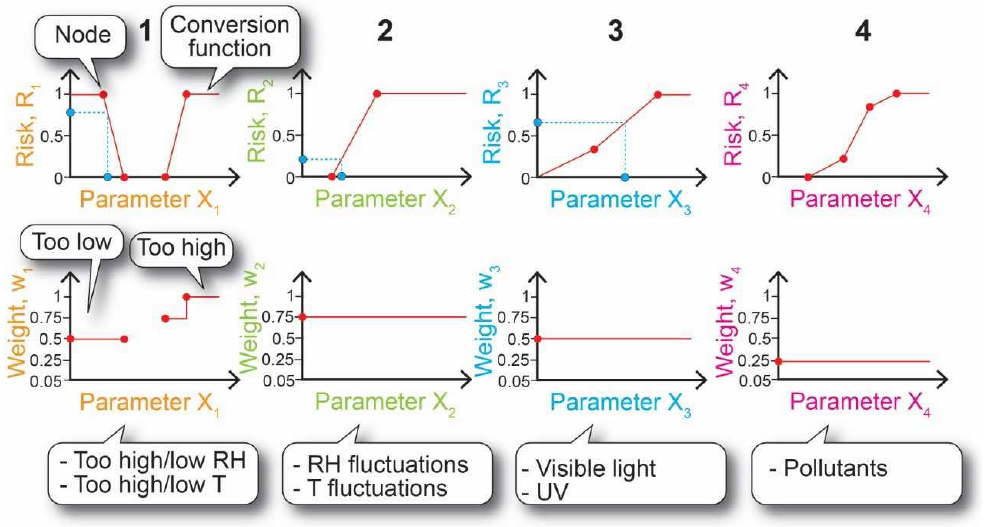
Figure 2. Conversion functions to calculate the level of risk that a marker is generating for a specific material or object type (upper part) and the way a weight is attributed to a key risk indicator (KRI) (lower part).